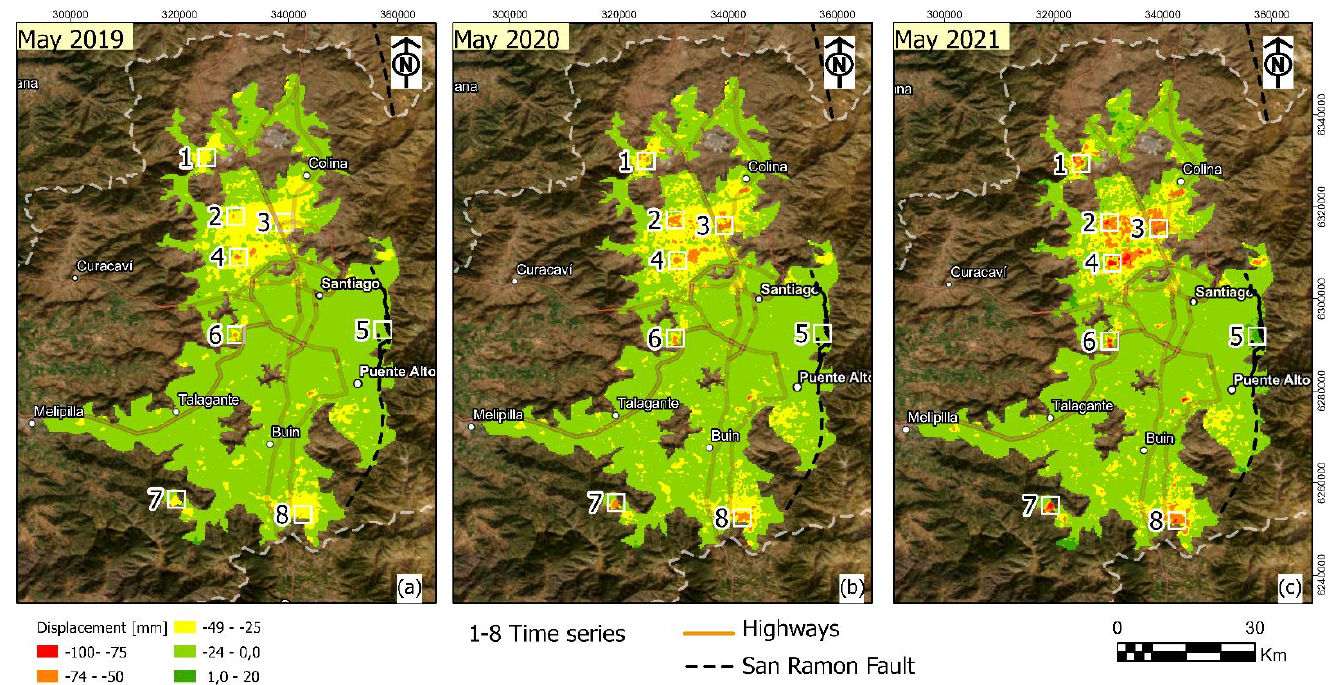
Figure 5. Map of cumulative displacements and temporal evolution ( a ) Recorded in May 2019 ( b ), Recorded in May 2020, and ( c ) Recorded in May 2021, with Maxar image (source Esri) used as background. Numbers in each panel label the localities in which the deformation time series response is described in the text of Section 4.3.